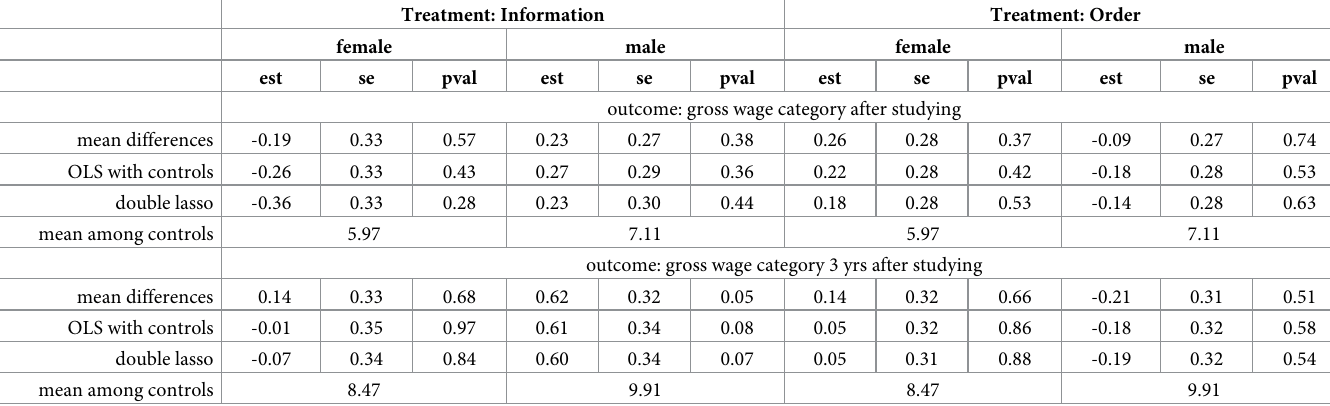
Table 4. Intervention effects. Treatment: Information Treatment: